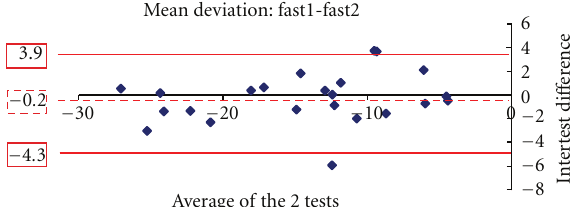
Figure 5: The Bland-Altman plot showing agreement in number of depressed points at least at P < 2% between the first and second visit 10-2 SITA-standard tests. The dashed line marks the average di ff erence between the two algorithms. The solid lines mark the upper and lower limits of the 95% limits of agreement.